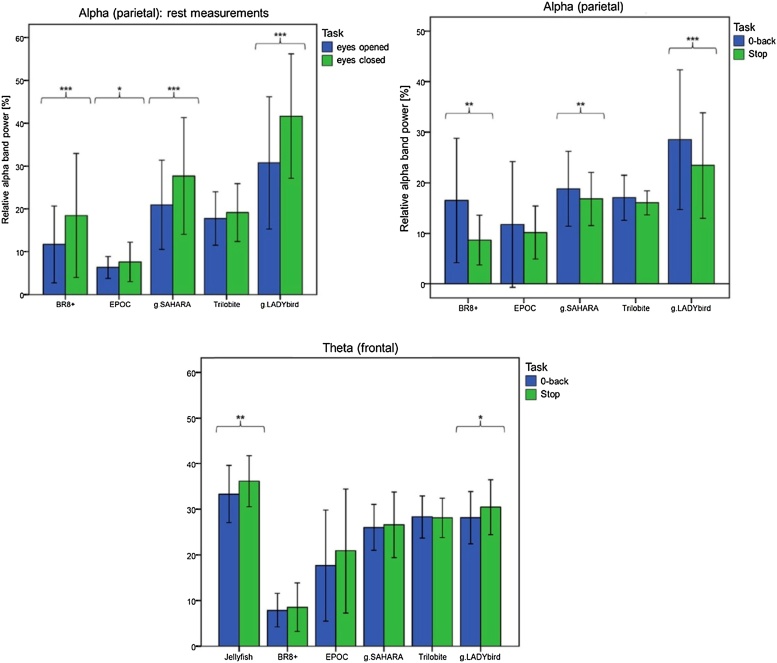
Example of spectral features detected by different mobile EEG systems (***: p ≤  .001; **: .001 < p ≤  0.01; *: .01 < p ≤  .05; error bars indicate ±1 SD). Top panels show that, as expected, parietal alpha-band power significantly increased from an eyes-opened to an eyes-closed resting condition (except for Trilobite – a dry system), and from an easy to a more demanding cognitive-task condition (except for Trilobite and EPOC, the latter being a saline-based system). Bottom panel shows that the expected frontal theta-band power significantly increased from an easy to a more demanding cognitive-task condition only in two systems, one which is research-grade and gel-based (g.LADYbird), and one dry system (which only had frontal electrodes called Jellyfish). Results were aggregated across a selection of electrodes depending on the specific configuration of each system. Depiction of some of these systems can be found in Fig. 1. Adapted from Radüntz (2018).